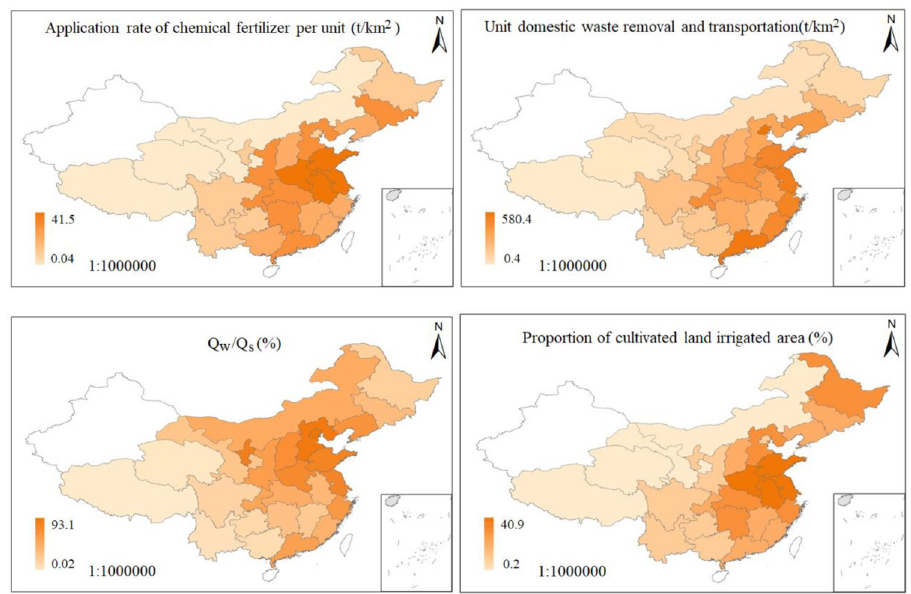
Fig 9. Spatial distribution map of factors directly affecting water quality(Q w - Total wastewater discharge per unit area(t/km 2 );Q s -Surface water resources per unit area(m 3 /km 2 ))